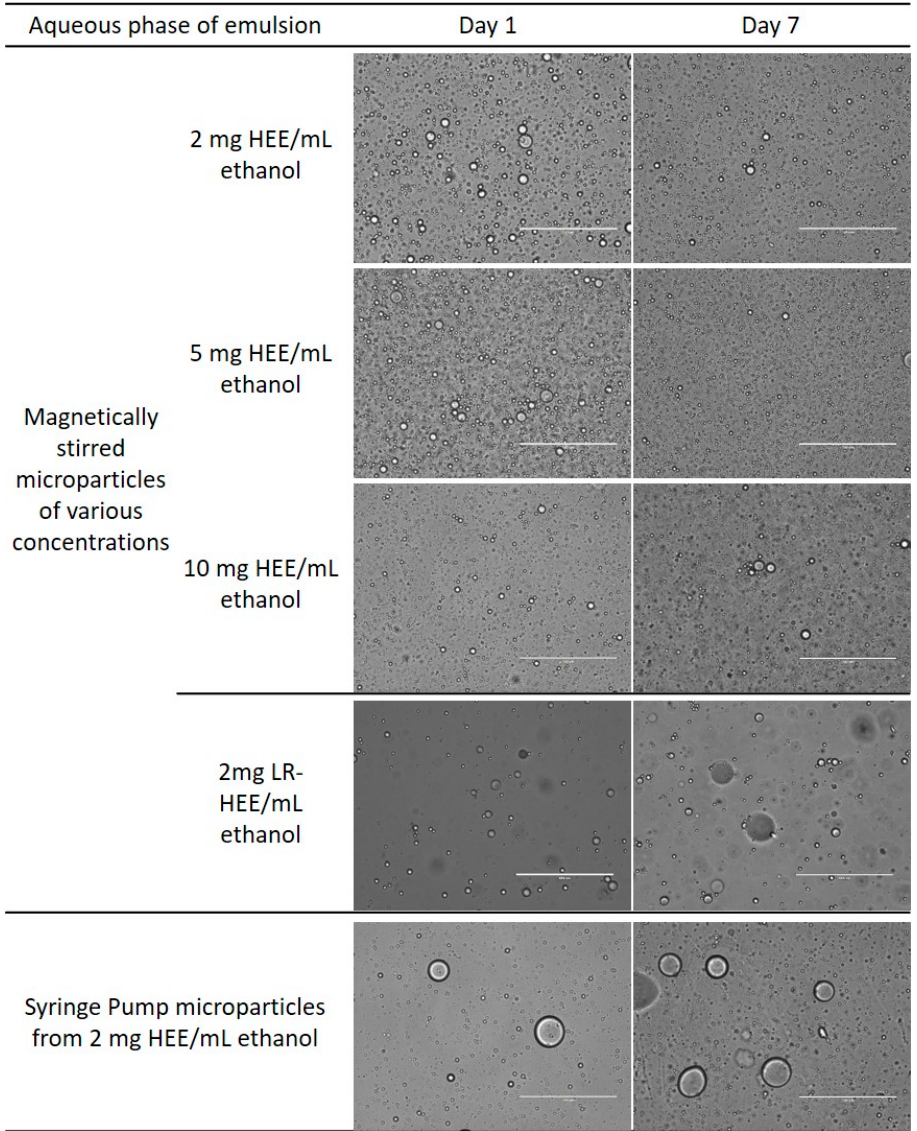
Figure 5. Microstructure of o/w emulsions 1 and 7 days post production. Scale bars represent 100 µm. The corresponding droplet size distributions for day one are depicted in Figure 6A.